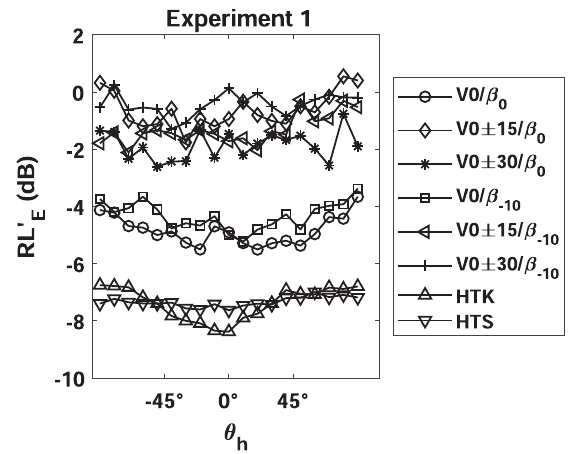
Figure 12. RL 0 calculated for VAH BRIRs of subject 1 and the E HTK and HTS BRIRs. RL 0 was calculated for the frontal source E in the lecture